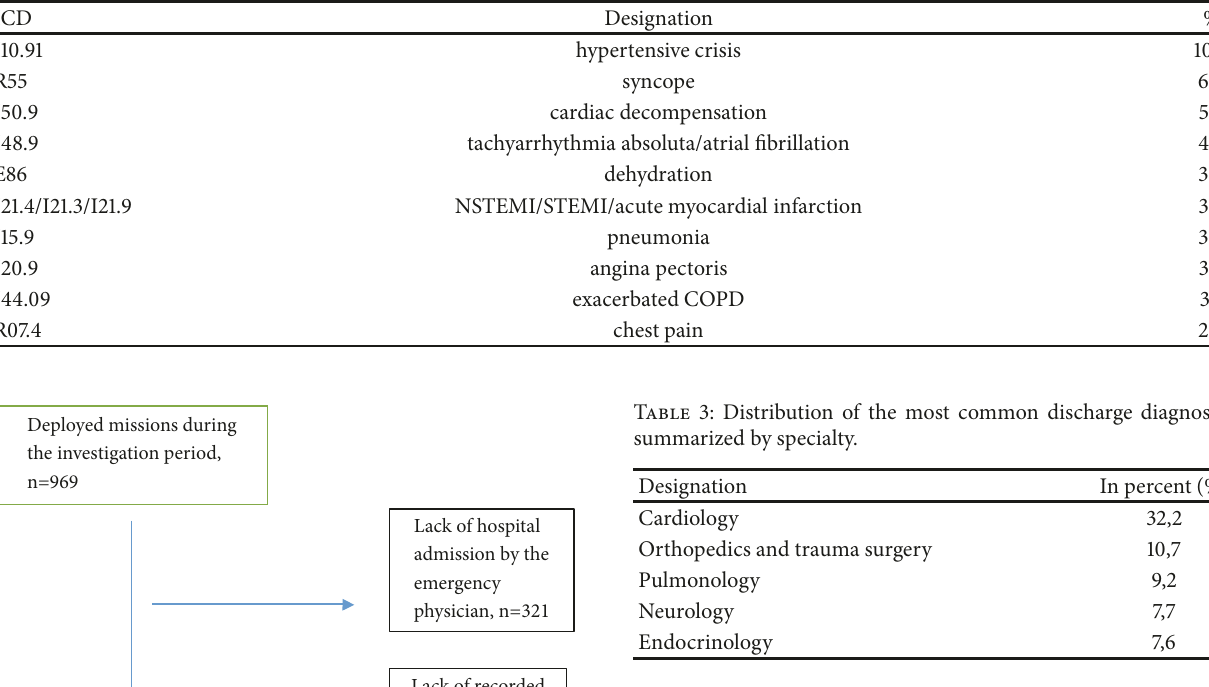
Table 2: 10 most common discharge diagnoses (n=747).